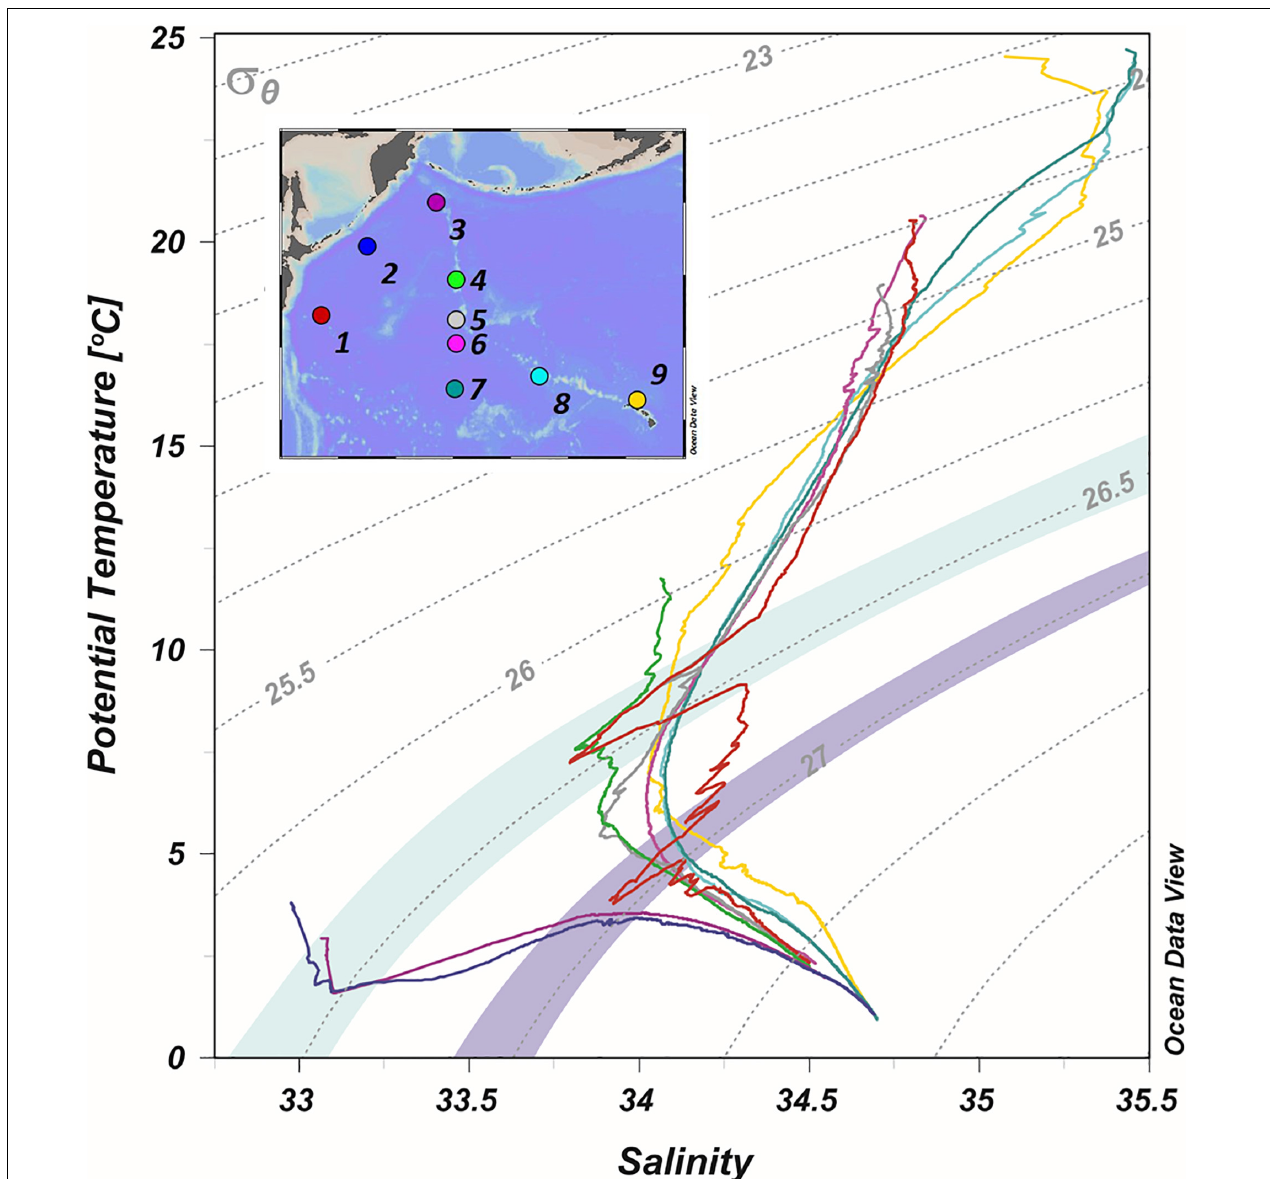
FIGURE 8 | Temperature-salinity profiles for all stations, shown with isopycnal layers (dashed lines). Shaded areas show density ranges for the upper (green, 26.3–26.6 σ θ ) and lower (purple, 26.9–27.1 σ θ ) low temperature-low salinity intrusions.